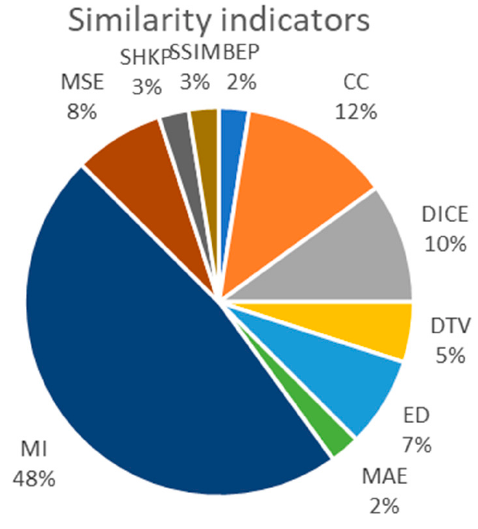
Figure 3. Repartition of similarity indicators used in reviewed articles.